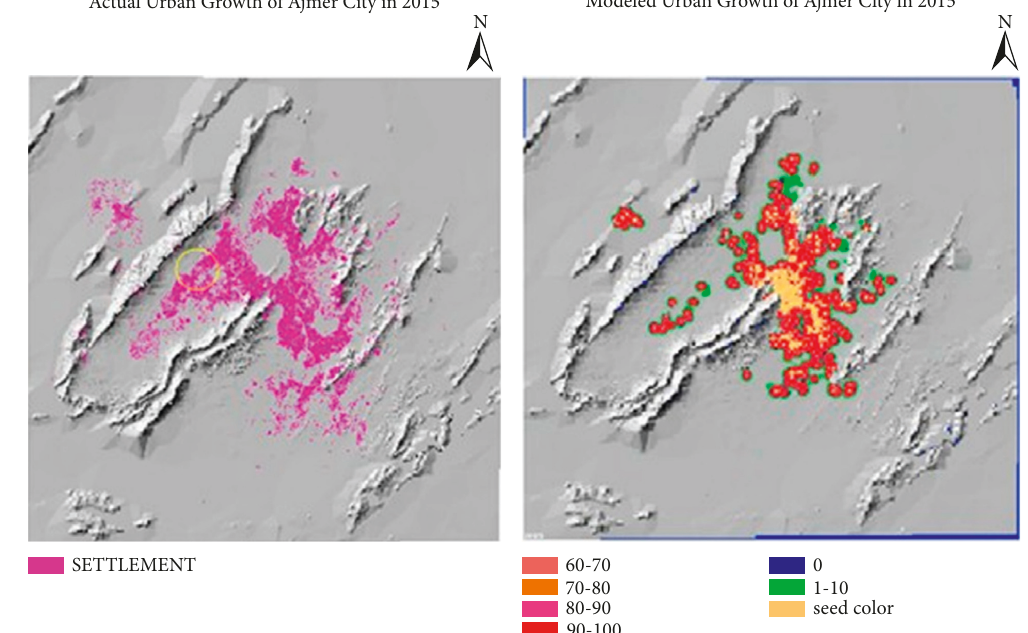
Figure 4: Simulation of 2015 LR-CA patterns and three metaheuristic CA models